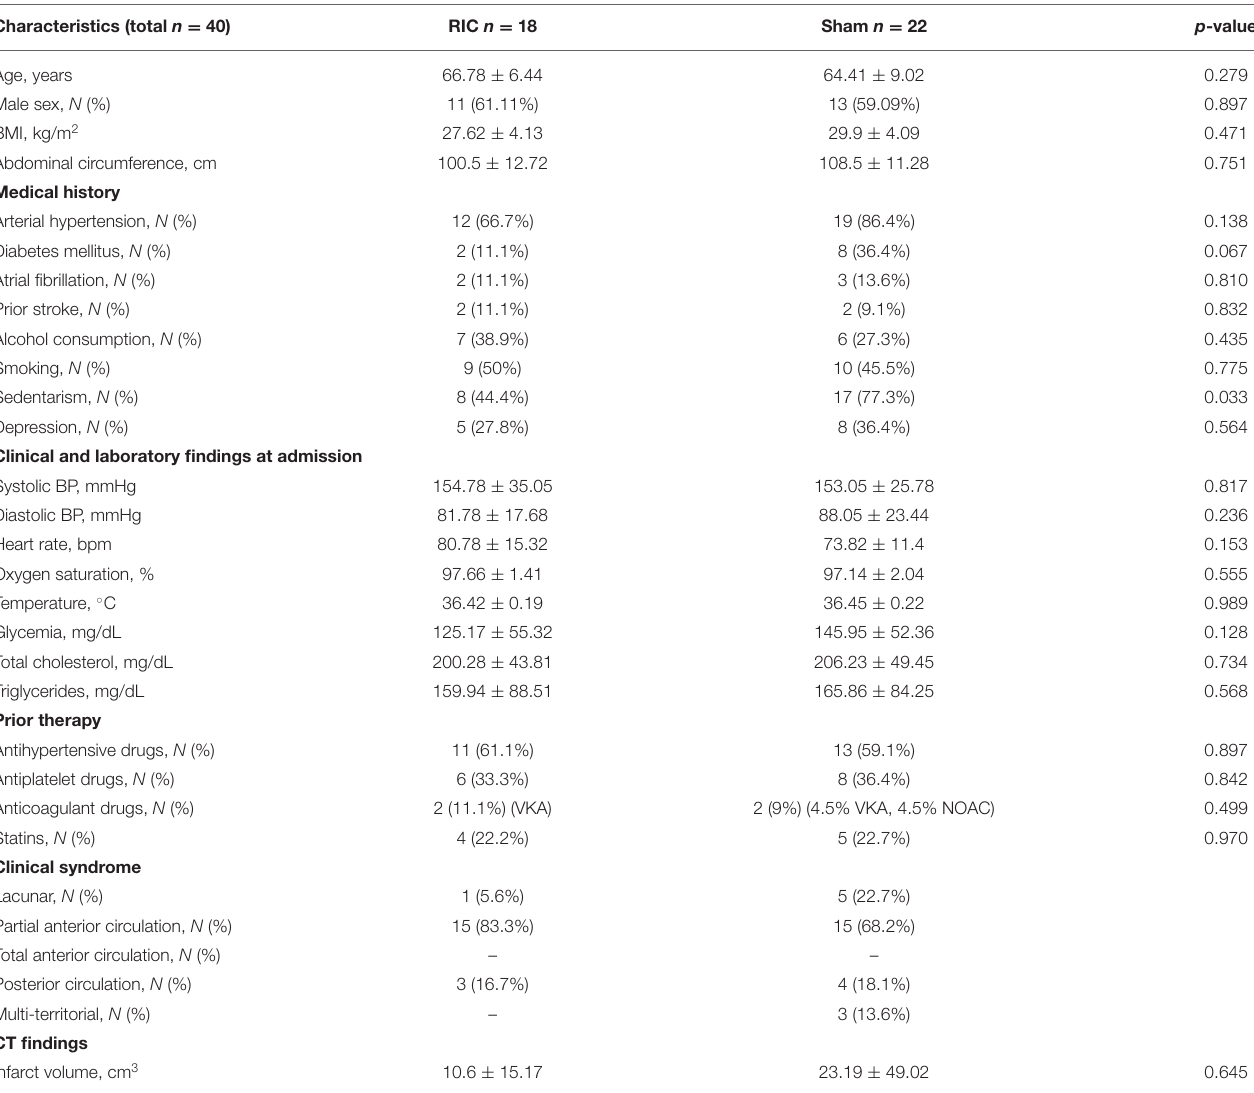
TABLE 2 | Baseline characteristics in the two groups. Characteristics (total n =